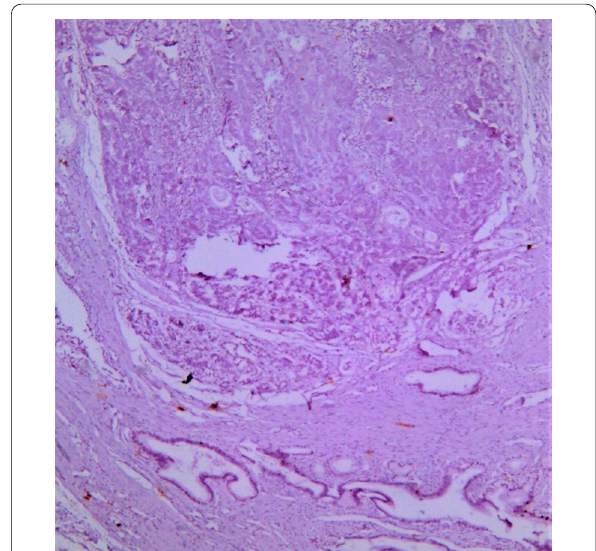
Fig. 5 Negative immunostain of chromogranin (low power)